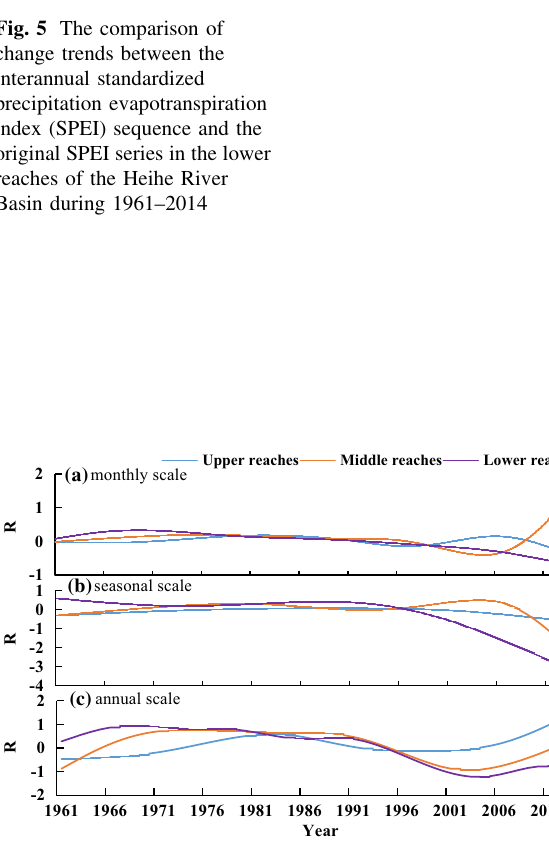
Fig. 6 The overall trends at different timescales based on extreme- point symmetric mode decomposition (ESMD) in the Heihe River